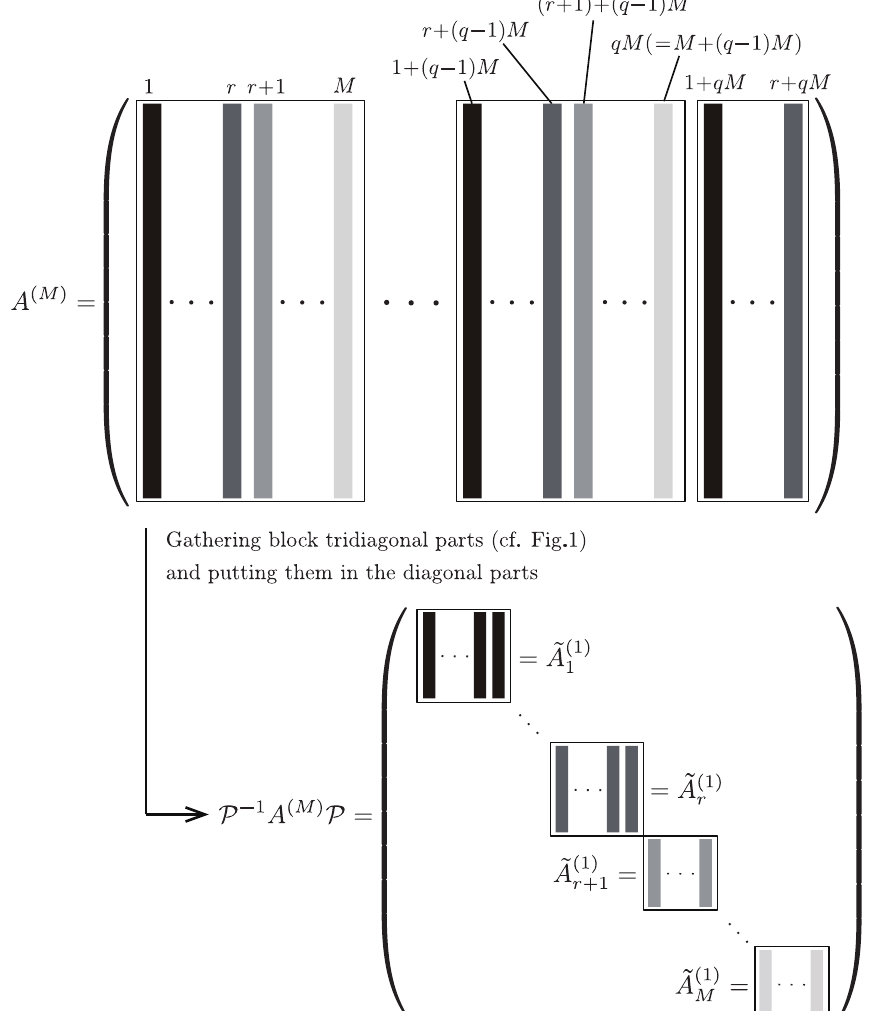
Figure 2. A block tridiagonalization of the block M -tridiagonal matrix A ( M )